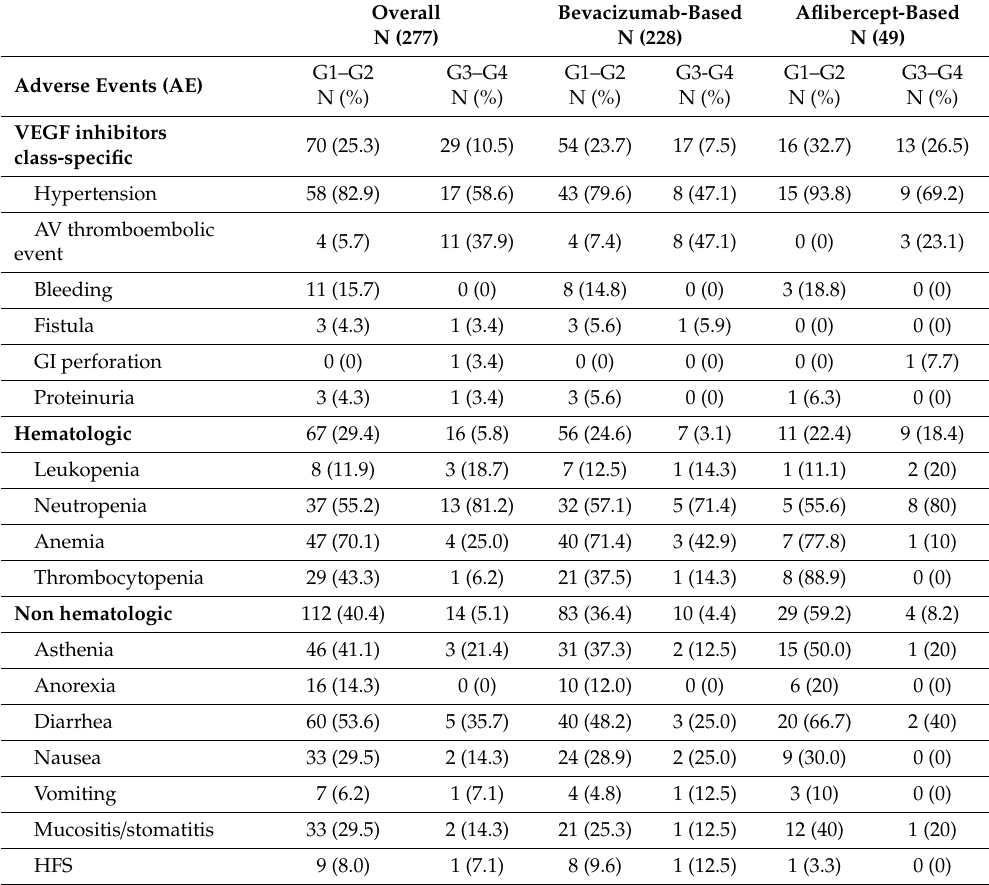
Table 5. Adverse events in overall, Bevacizumab-based and Aflibercept-based